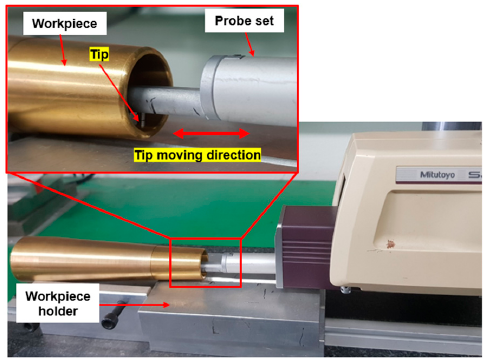
Table 3. Experiment Conditions.